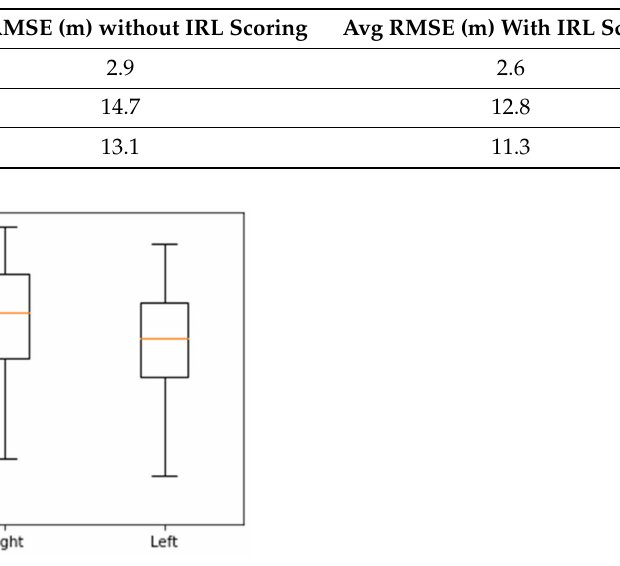
Figure 3. Boxplot of RMSE values by movement.